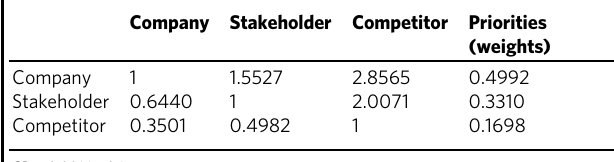
Table 6 Aggregated pairwise comparison matrix of main